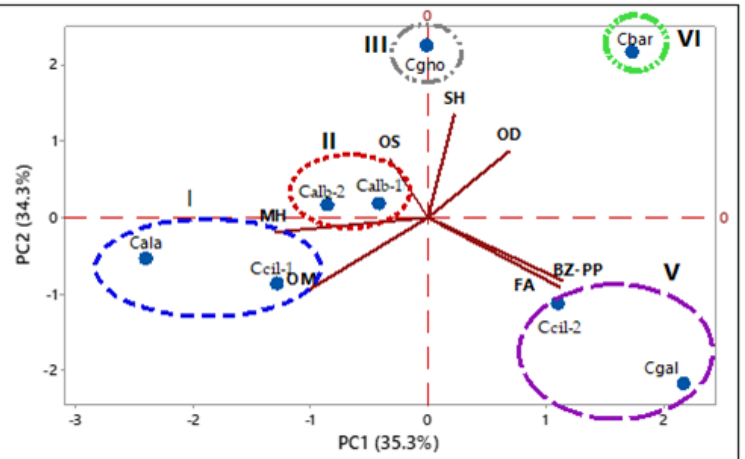
Figure 14. Principal componente analysis (PCA) of the Catasetum volatile concentrates, Based on their classes of compounds.